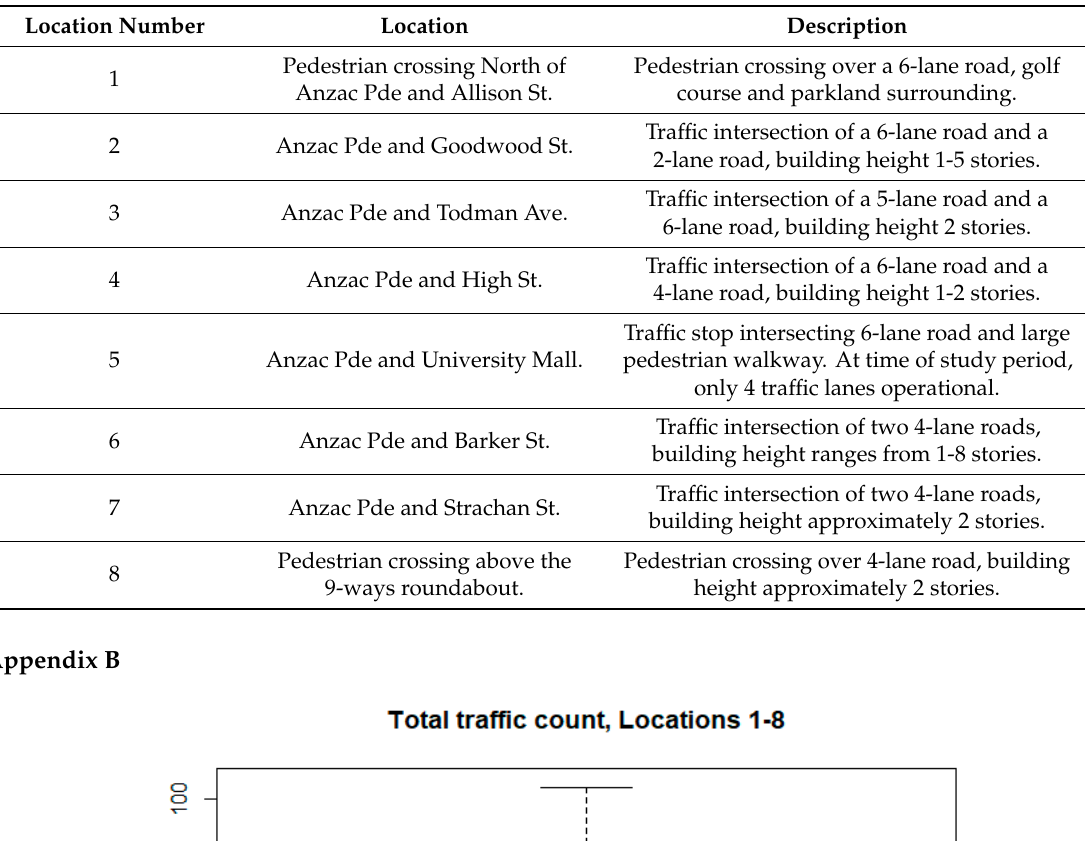
Table A1. Tra ffi c counting locations and